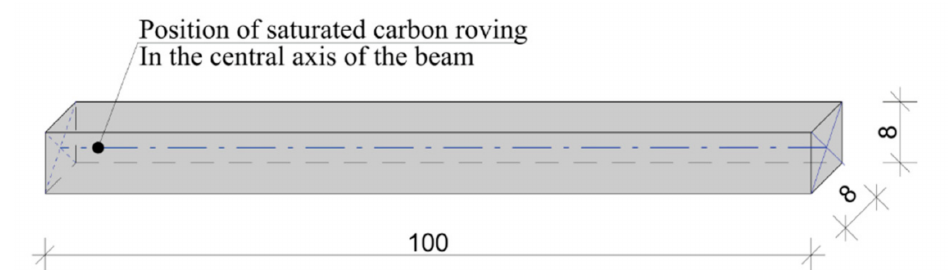
Figure 6. Description of the beam sample with the position of the saturated roving (unit: